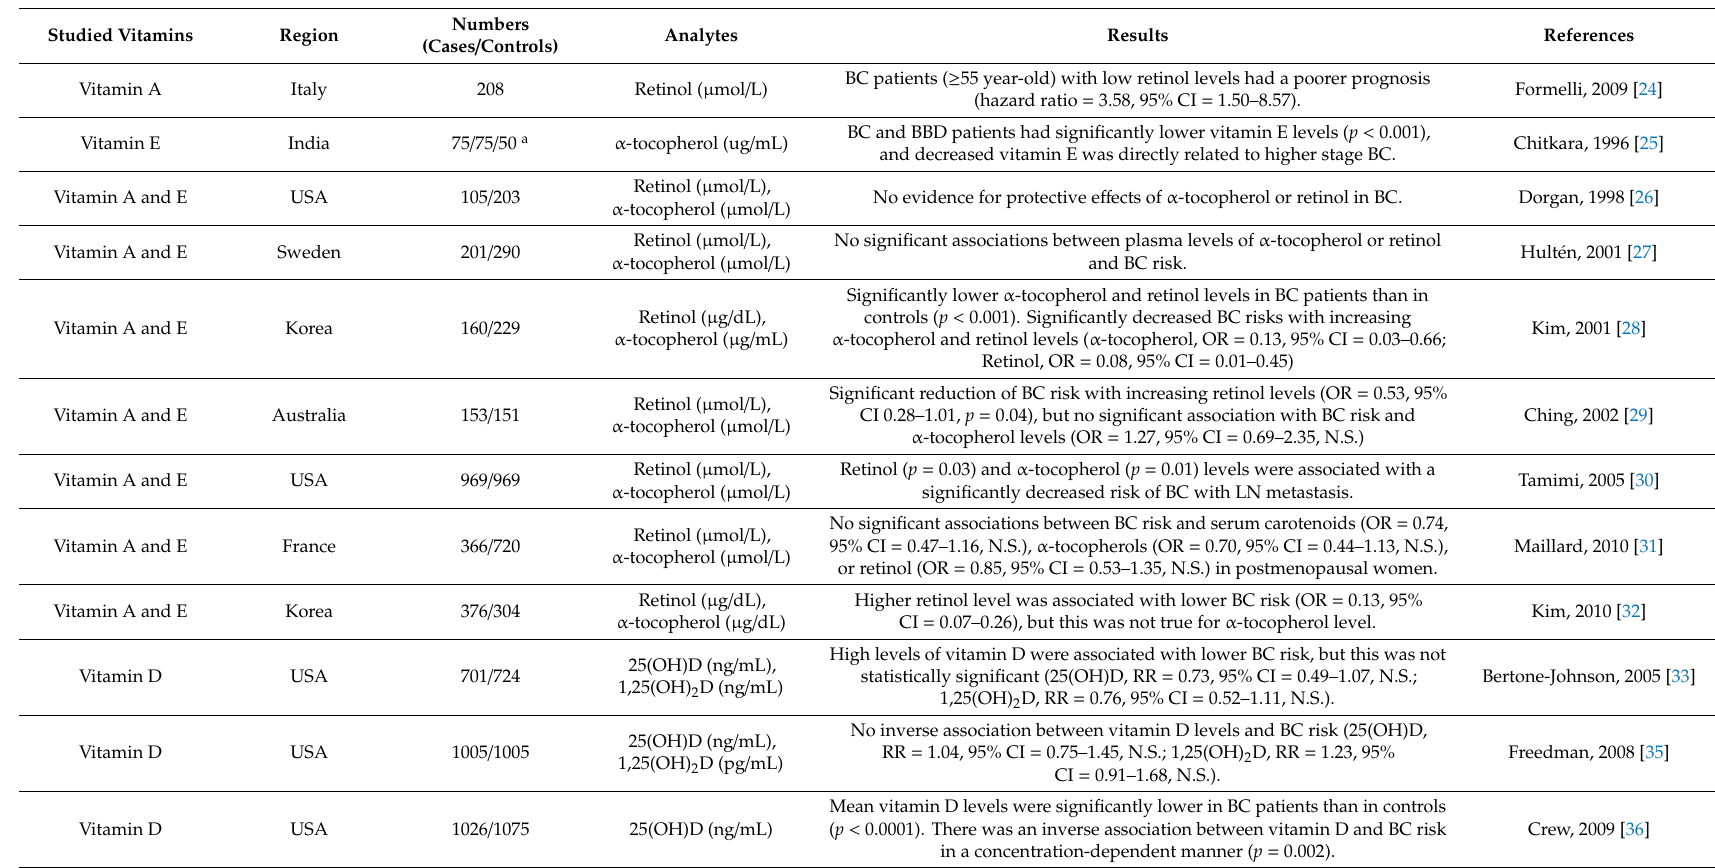
Table 6. A summary of previous studies of vitamin status in patients with breast